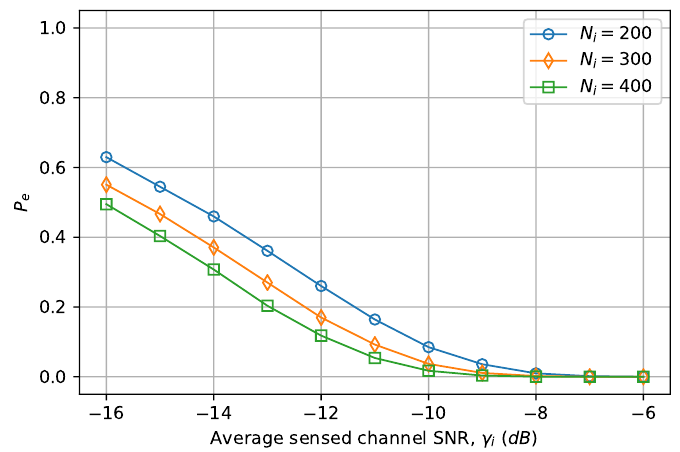
Figure 11. Probabilities of detection and false alarm according to average SNRs when the number of sensing samples for each SU changes.